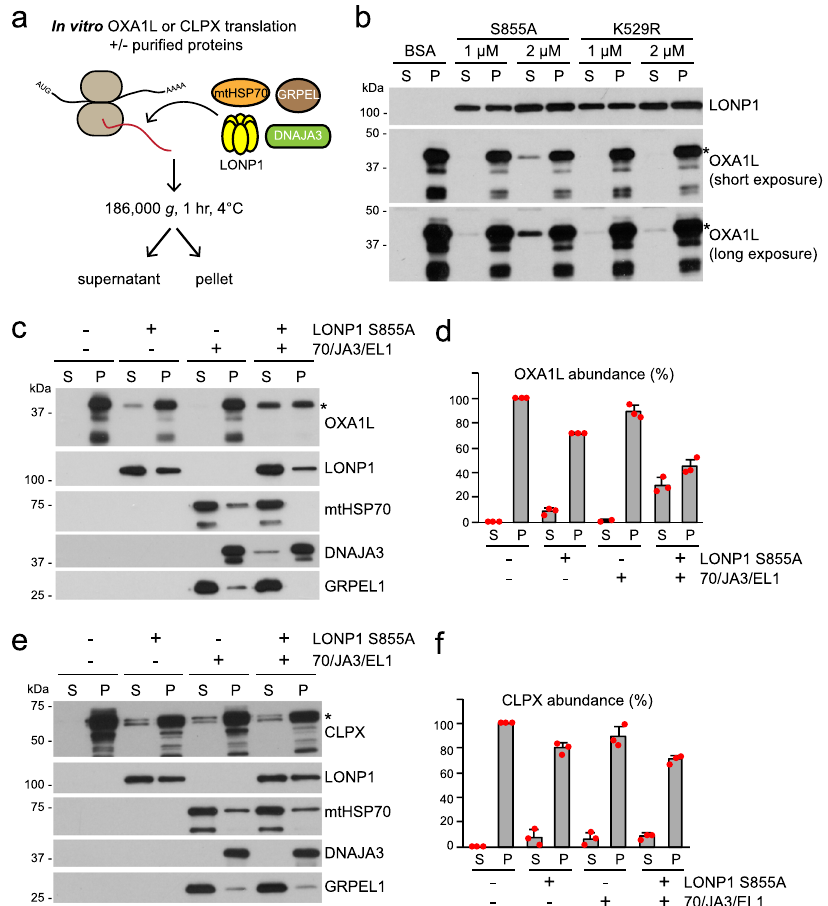
Fig. 5 In vitro reconstitution of OXA1L and CLPX solubilization. a Schematic of in vitro translation in the presence of recombinant LONP1 and mtHSP70 chaperone components. b Analysis of OXA1L solubility in the presence of protease-de fi cient LONP1 S855A or ATPase-de fi cient LONP1 K529R . An asterisk (*) indicates full-length OXA1L. c – f Analysis of OXA1L and CLPX solubility in the presence of LONP1 S855A plus mtHSP70 chaperone components (4 μ